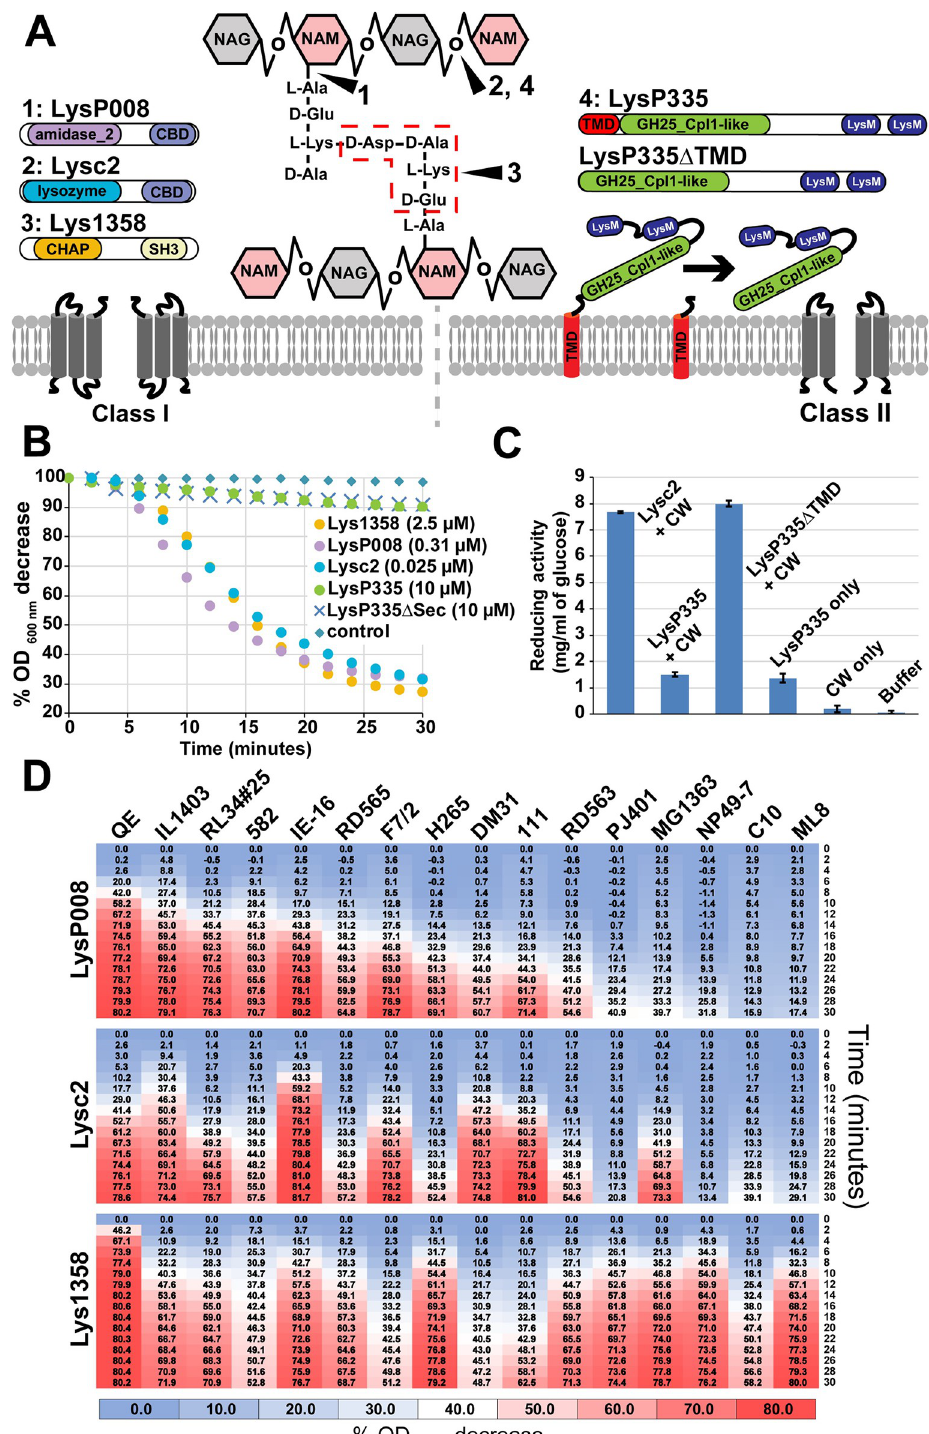
Fig 2. Biochemical characterization of the endolysins of the lactococcal phages P008, c2, 1358, and P335. ( A) The endolysin of phage P008 (LysP008) is composed of an amidase_2 CD that is known to hydrolyse the glycan–peptide linkage and a C-terminal region with homology to the CBD of the endolysin found in the Enterococcus phage IMEEF1 [26]. The endolysin of phage c2 (Lysc2) has a lysozyme-like CD that can hydrolyse the glycosidic bonds between the sugar moieties and a C-terminal region that also shares homology with the CBD of phage IMEEF1 endolysin [26].